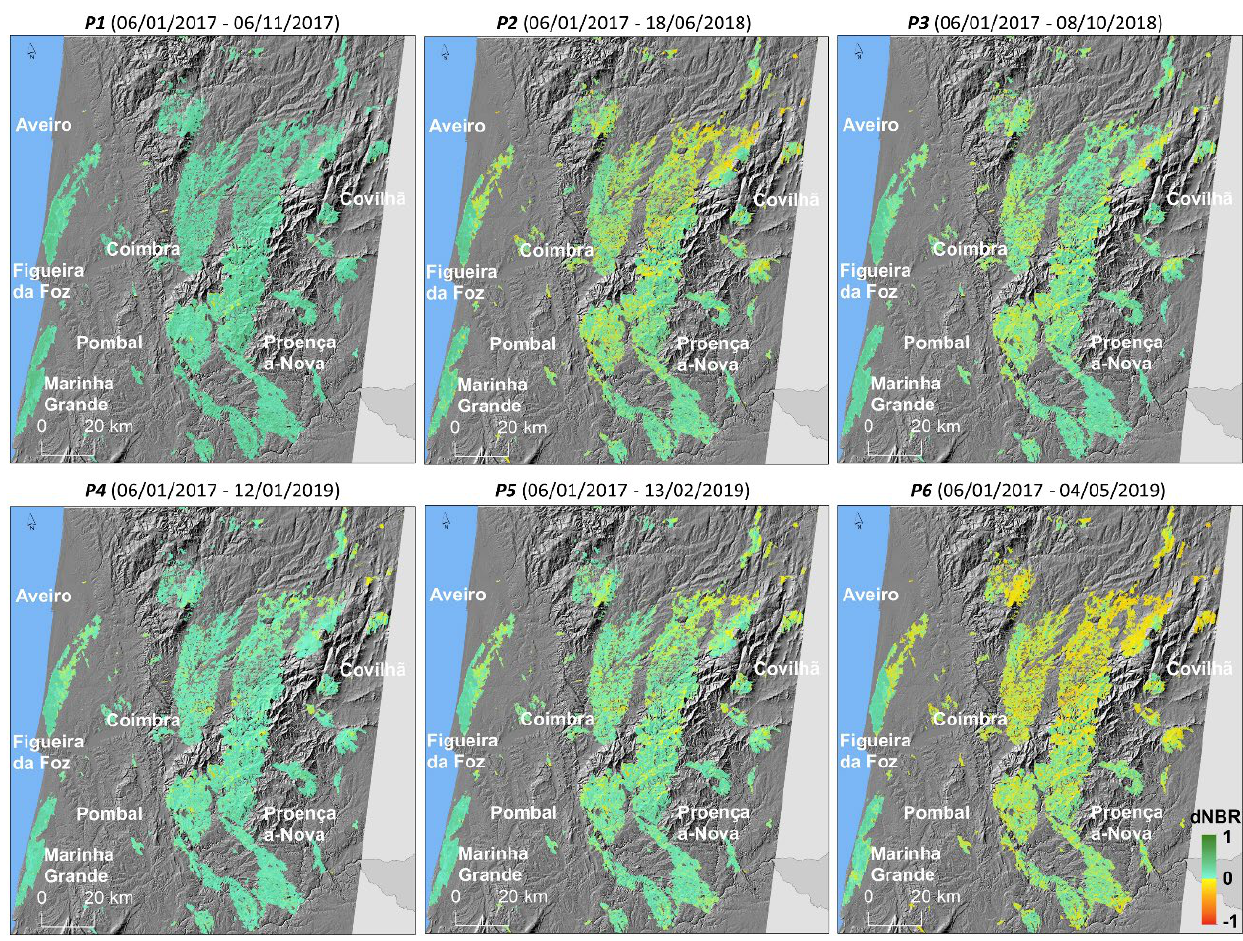
Figure 5. Differenced NBR product (dNBR) of burned areas in study area.